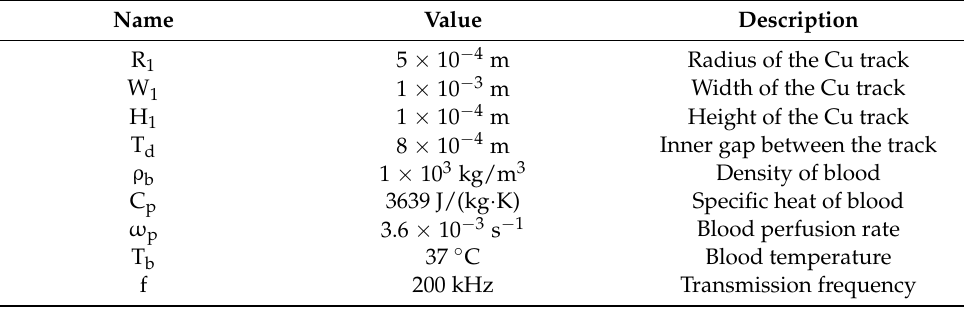
Table 4. Parameters used for the in silico model